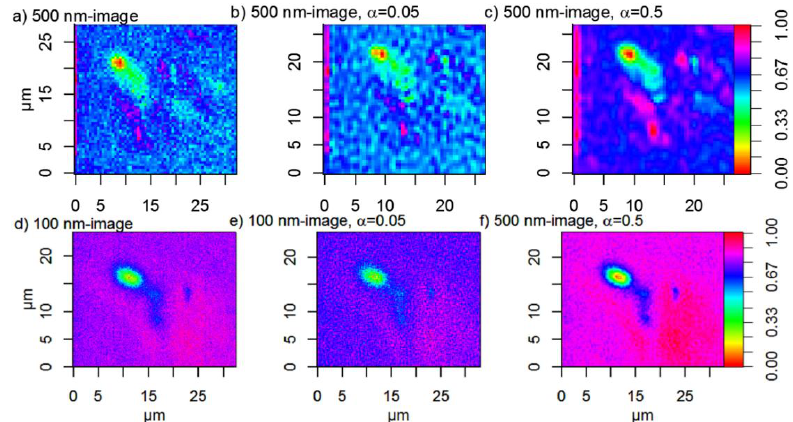
Figure 9. Normalized images of PC2, i.e. , score values ranging from 0 to 1. ( a ) 500 nm image; ( b ) 500 nm image treated with super-resolution algorithm, α = 0.05; ( c ) 500 nm image treated with super-resolution, α = 0.5; ( d ) 100 nm image; ( e ) 100 nm image treated with super-resolution algorithm α = 0.05; ( f ) 100 nm image treated with super-resolution algorithm, α = 0.5. Note that the (0,0) point is not the same in the 500 nm images and the 100 nm